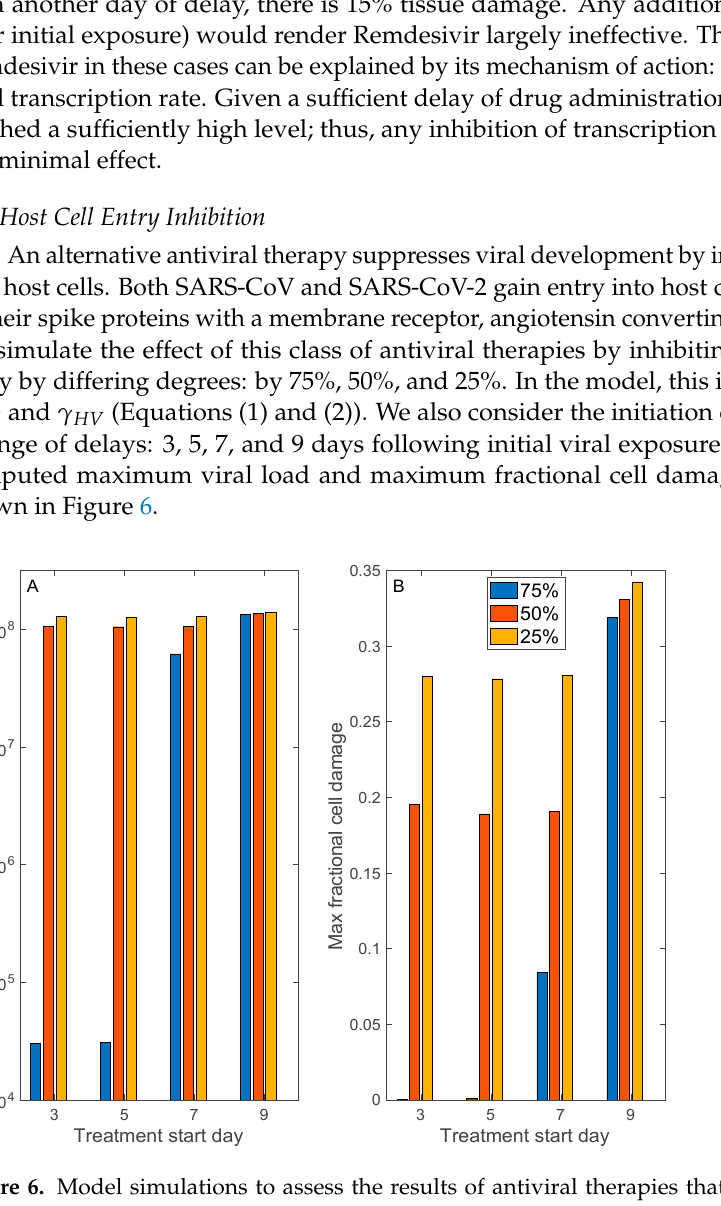
Figure 5. Effect of Remdesivir treatment on SARS-CoV-2 dynamics, and how that effect changes with treatment delay. Treatment may begin 9, 10, 11, or 12 days after initial viral exposure. Pre- dicted maximum viral load (Panel ( A )) and fractional cell damage (Panel ( B )) are shown. Blue bar,